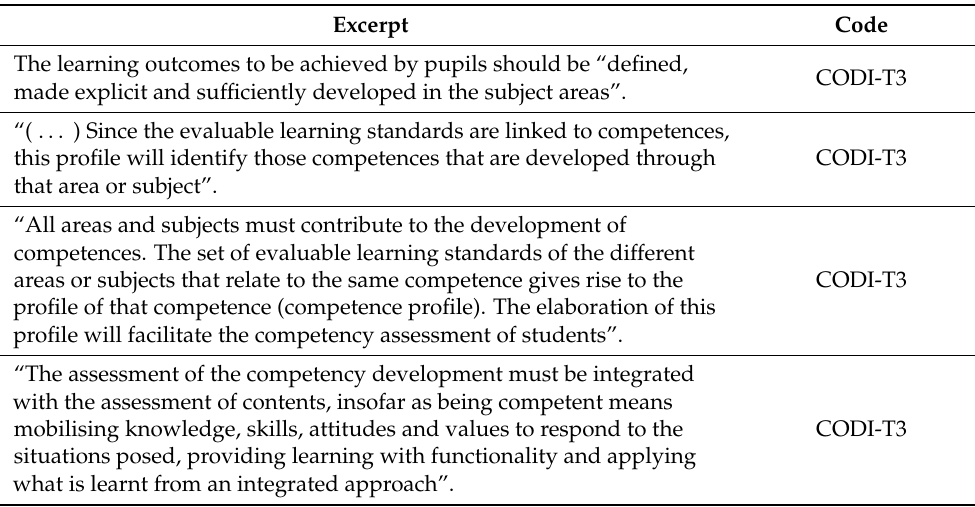
Table 4. Selection of excerpts from the Orden ECD/65/2015, de 21 de enero, on the topic guidelines for the integration of key competences in the curriculum